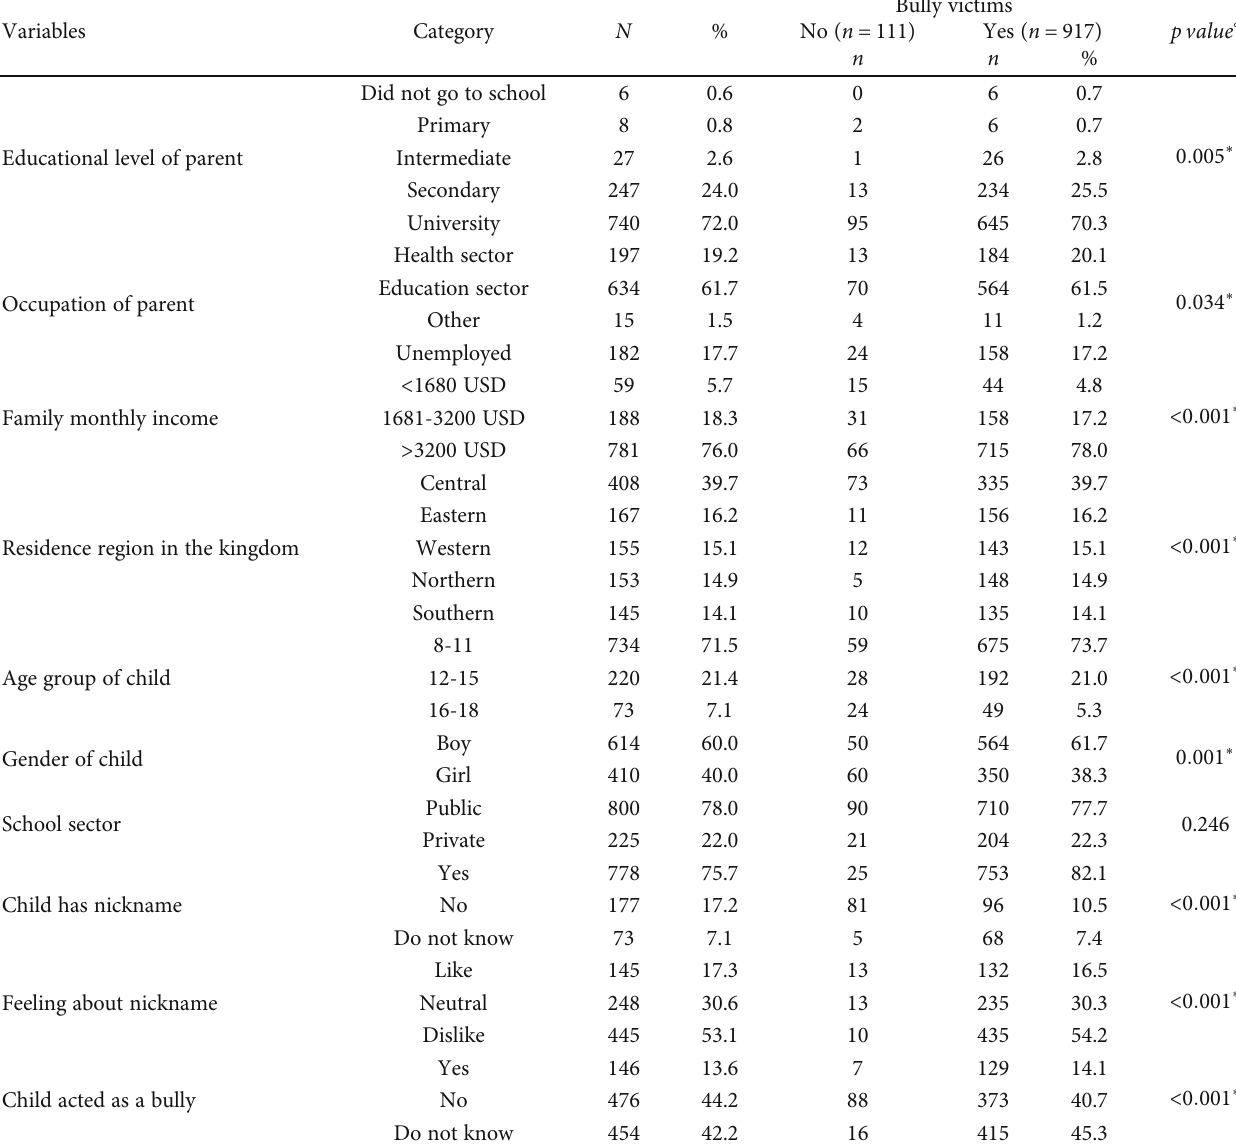
Table 1: Sociodemograhic characteristics of study participants and association with bullying ( n = 1028